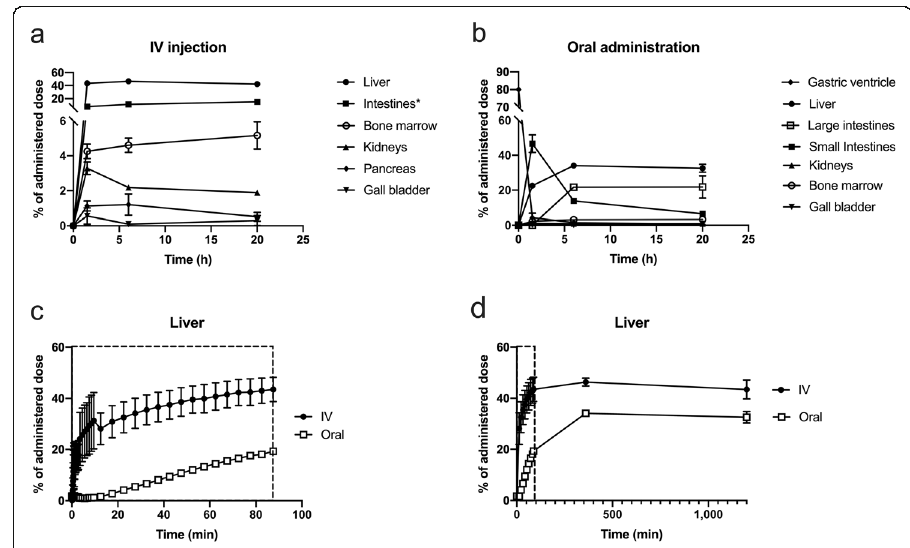
Fig. 2 Time courses of %AD in source organs following intravenous (IV) and oral administration of 64 Cu. Upper panels show the biodistribution of 64 Cu after IV ( a ) and oral ( b ) administration. Lower panels show %AD in liver tissue during the initial dynamic PET/CT scan ( c ; 90 min) and including static whole-body PET scans from the entire study period ( d ; 20 h); closed circles show the time course after IV administration, open circles after oral administration. All values are given as group means ± SD. *Summation of small and large